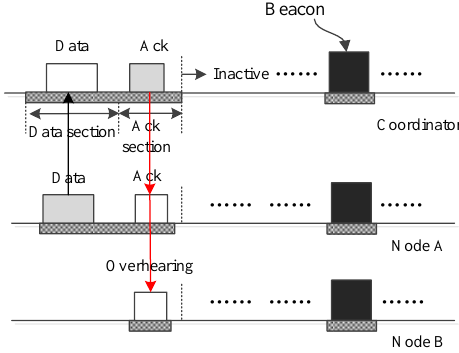
Figure 11. Only one node sends small data to the